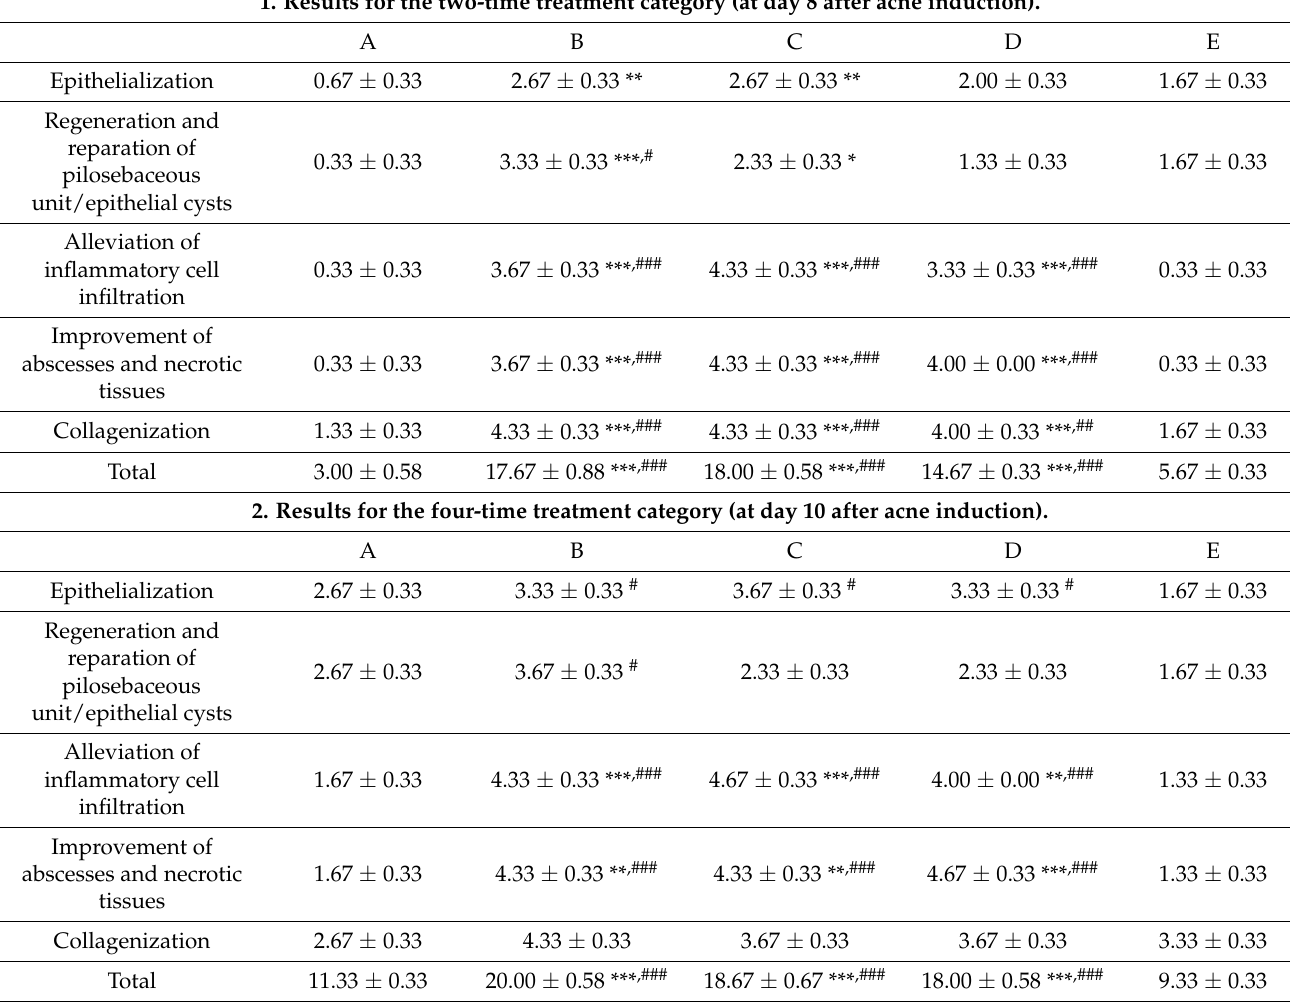
Table 1. Tissue repair scores for the epidermis and dermis of the rats that received C. acnes and were treated using farnesol, commercial antibiotic gel, or were untreated in the two- and four-time treatment